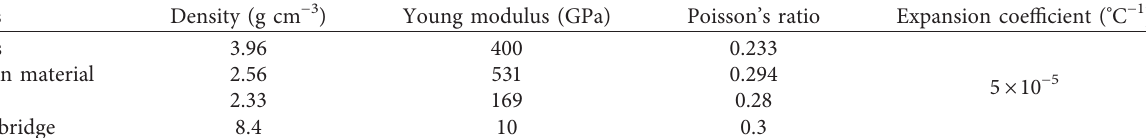
Table 1: Mechanical parameter of material.